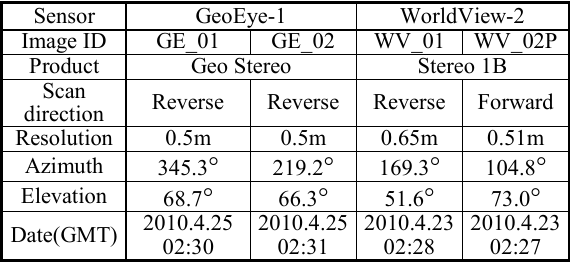
Table 1. Properties of the used satellite images Seventeen Ground Control Points (GCPs) were collected in the test area with 3cm in horizontal and 5cm in vertical The GCPs were used as control points for RPC modeling and check points for evaluating the geometric accuracy of RPC modeling. Figure 1 shows the configuration of the GCPs.